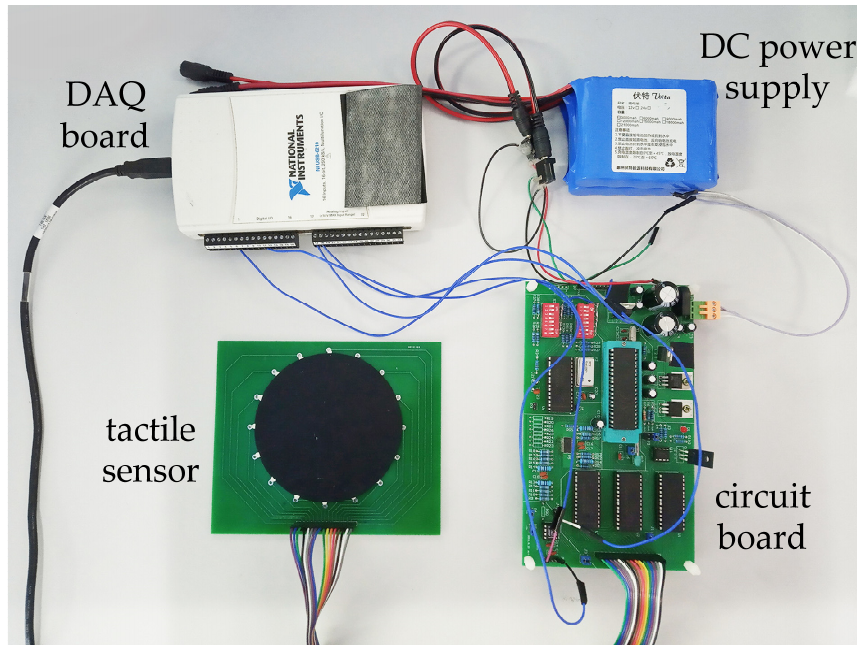
Figure 6. The hardware system of proposed sensor.